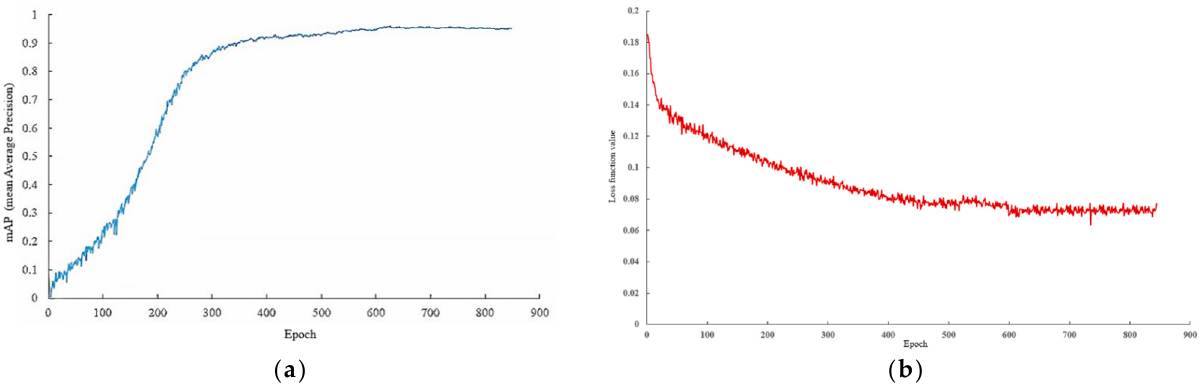
Figure 10. ( a ) mAP curve; ( b ) Loss curve.